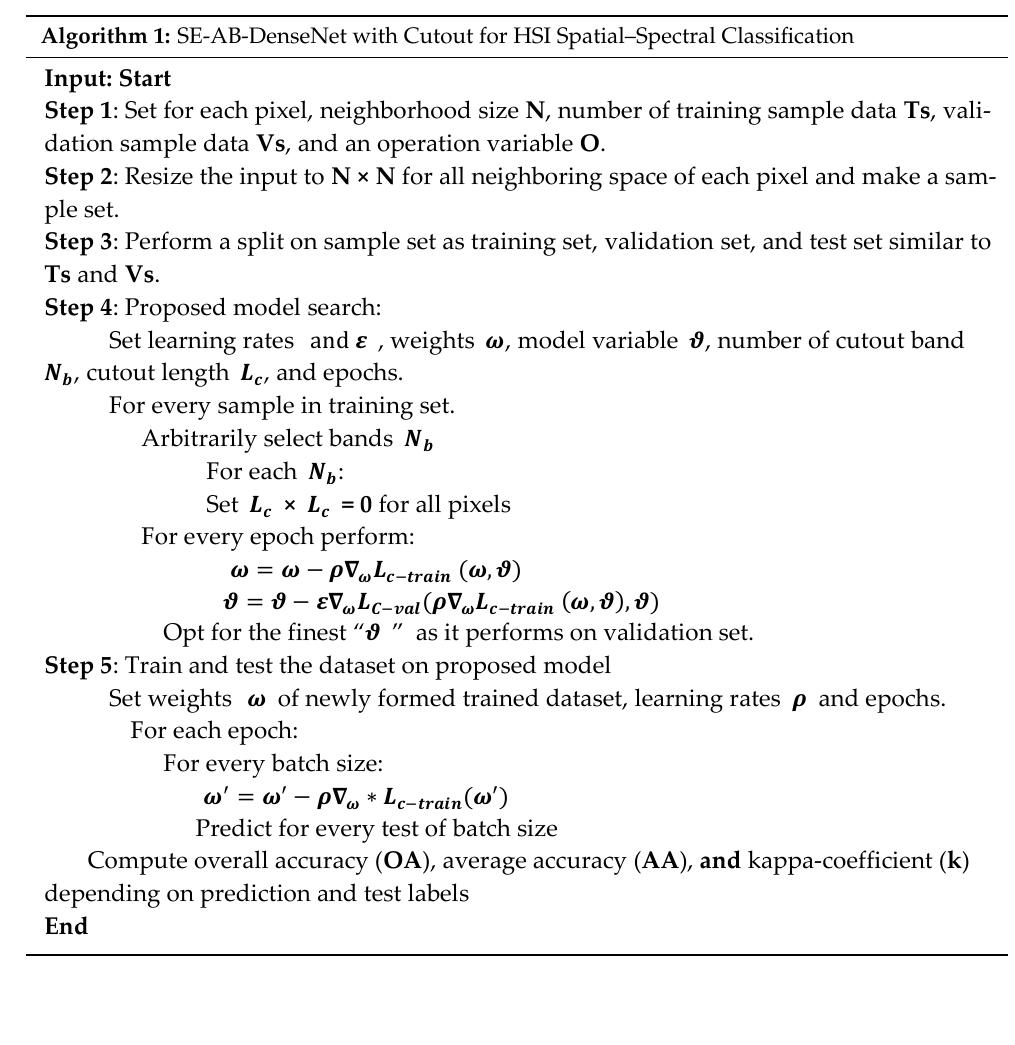
Sensors 2022 , 22 , x FOR PEER REVIEW 10 of 25